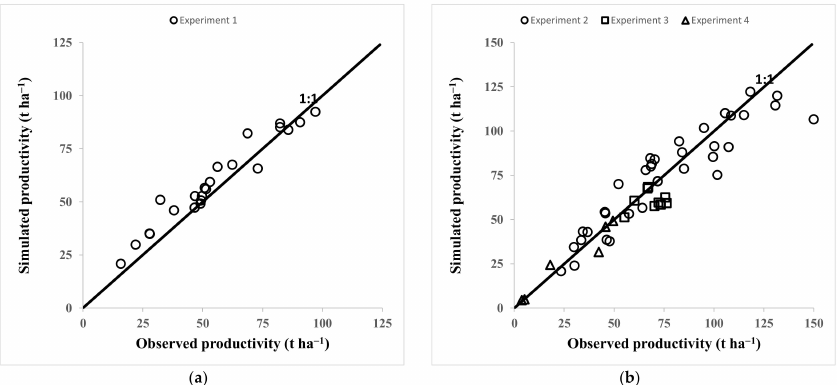
Figure 4. The predicted versus observed productivities of apple ( a ) and pear ( b ) crops, and their relation to the 1:1